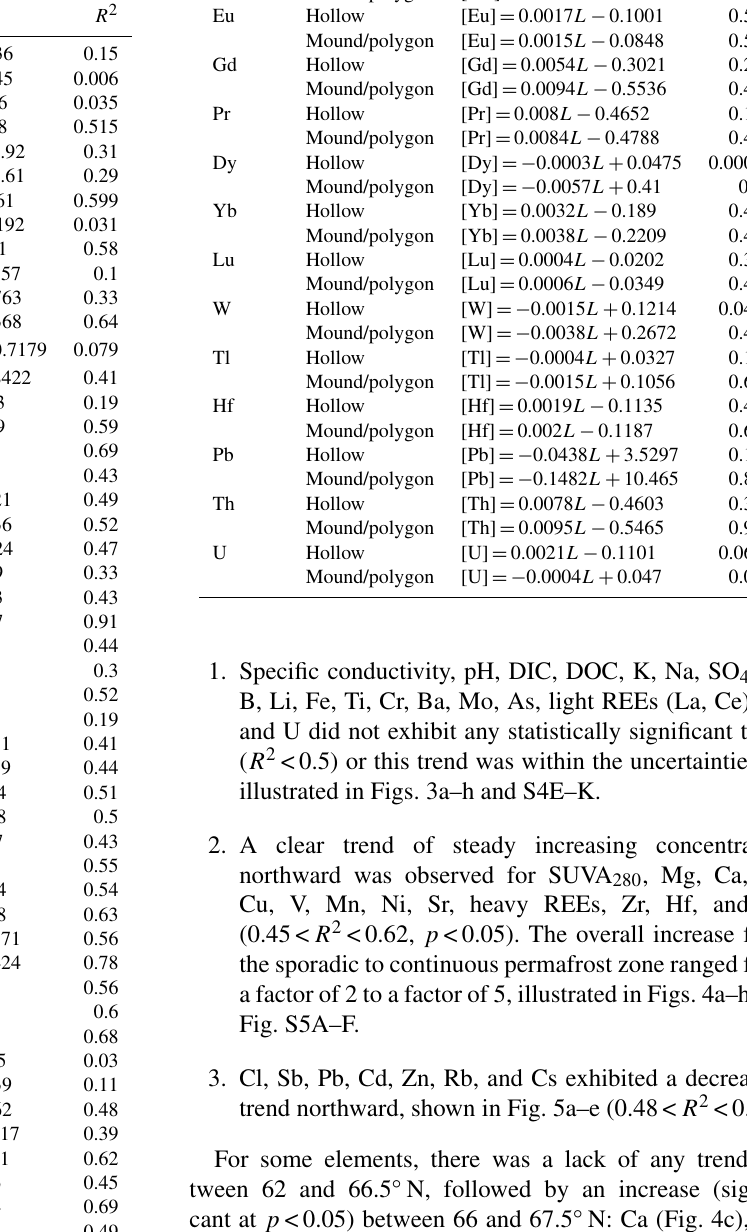
Table 3. Latitudinal trends of average element concentration in two main habitats persisting in all five study sites. L is for latitude ( ◦ N) and R 2 is a linear regression coefficient (Eq. 1). SC is specific con- ductivity.